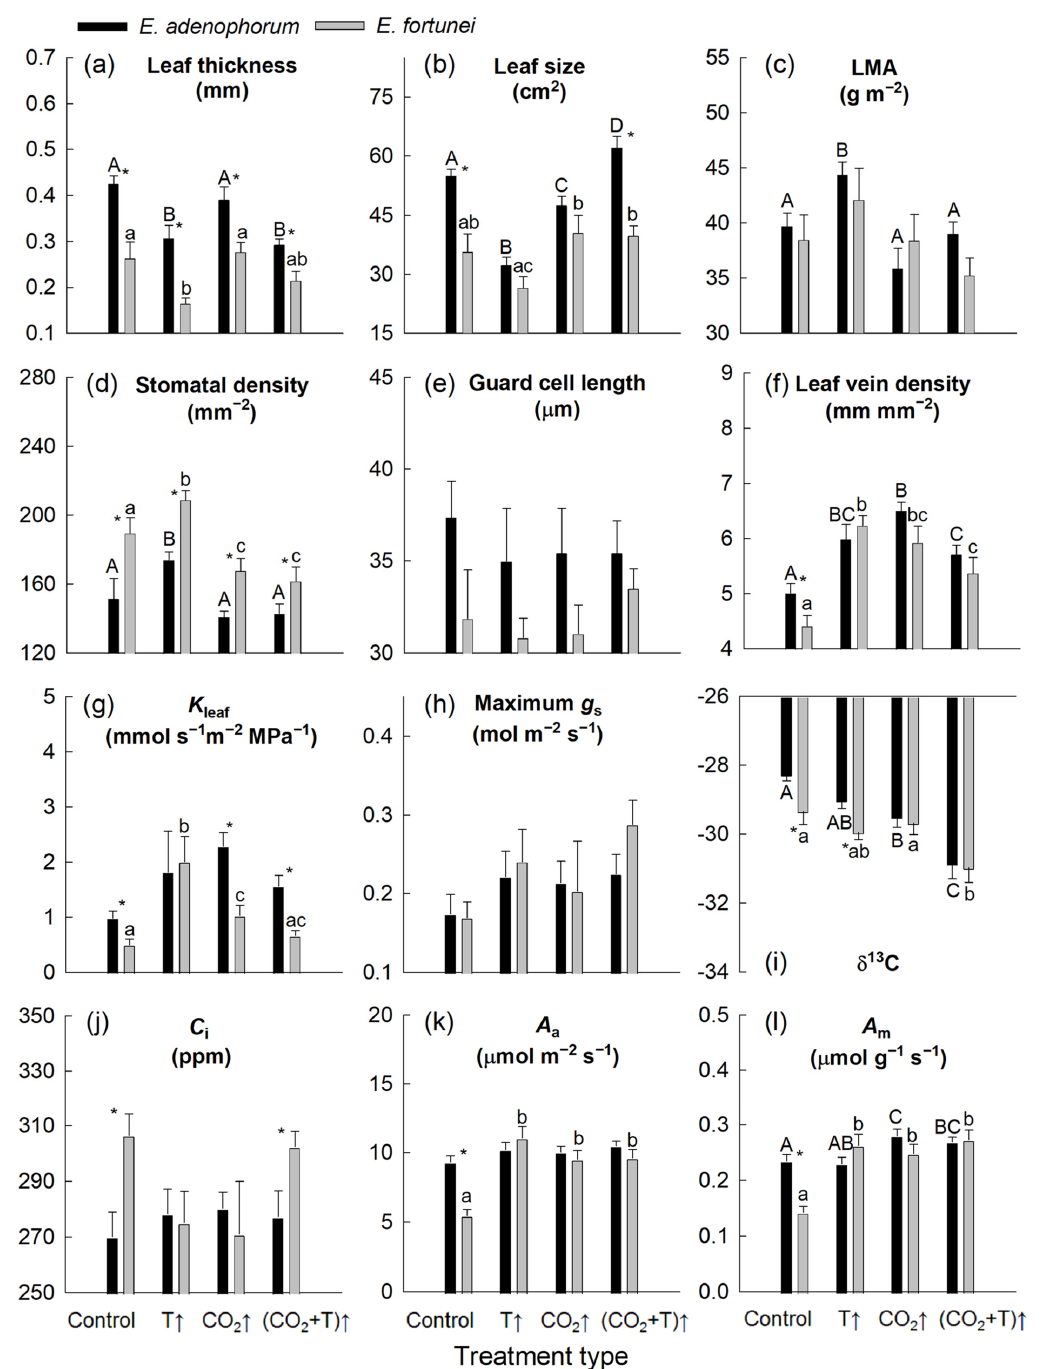
Figure 2. Leaf structural, hydraulic, and photosynthetic properties of Eupatorium adenophorum (invasive species) and E. fortunei (native species) under different treatments: control, elevated temperature (T ↑ ), Elevated CO 2 concentration (CO 2 ↑ ), and elevated both temperature and CO 2 concentration [(CO 2 + T) ↑ ]. ( a ) Leaf thickness; ( b ) leaf size; ( c ) leaf mass per area (LMA); ( d ) stomatal density; ( e ) guard cell length; ( f ) leaf vein density; ( g ) leaf hydraulic conductance ( K leaf ); ( h ) maximum stomatal conductance; ( i ) δ 13 C; ( j ) intercellular CO 2 concentration; ( k ) light-saturated photosynthetic rate per area ( A a ); ( l ) photosynthetic rate per mass ( A m ). Bars topped by the same letter do not differ significantly between treatment types within the species. Bars topped by * differ significantly between species within the treatment type.